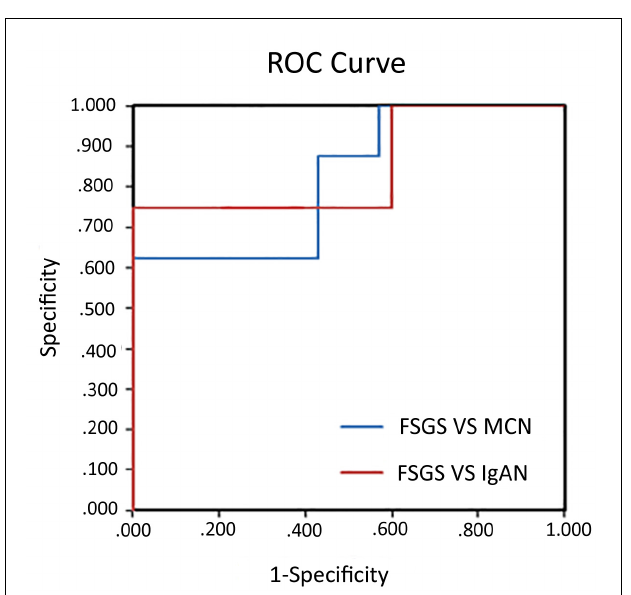
FIGURE 3 | Diagnostic values of urine exosomal miR-193a levels in patients with primary FSGS. ROC curve analysis of miR-193a expression to discriminate between primary FSGS patients and MCN or IgAN patients. The areas under the ROC curve were 0.85 and 0.821,